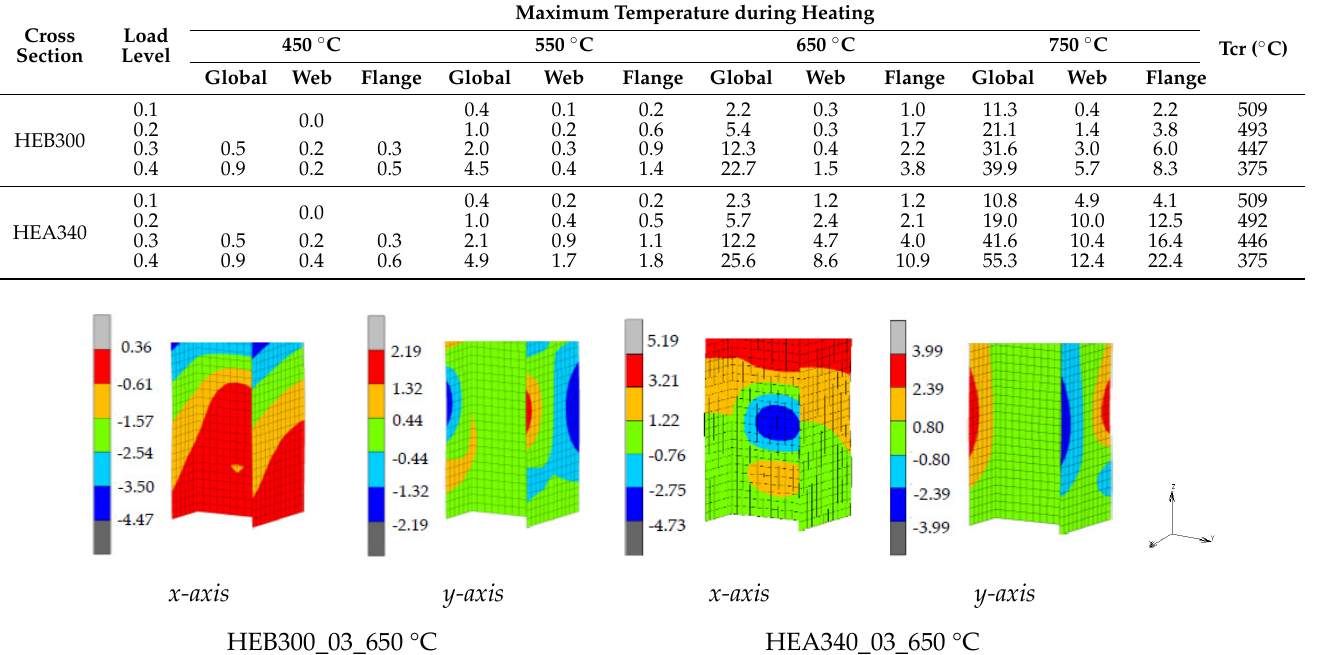
Table 2. Post-fire residual out-of-plane displacements (in mm).